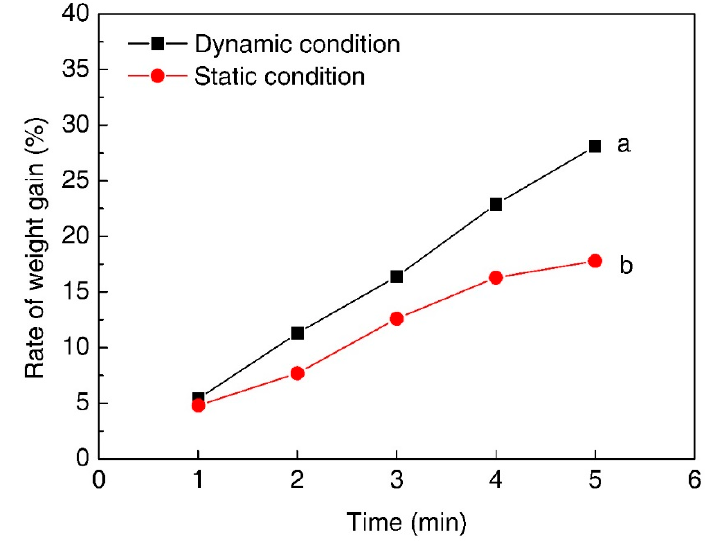
Figure 2. Deposition rate of silver particles under (a) dynamic, and (b) static conditions.